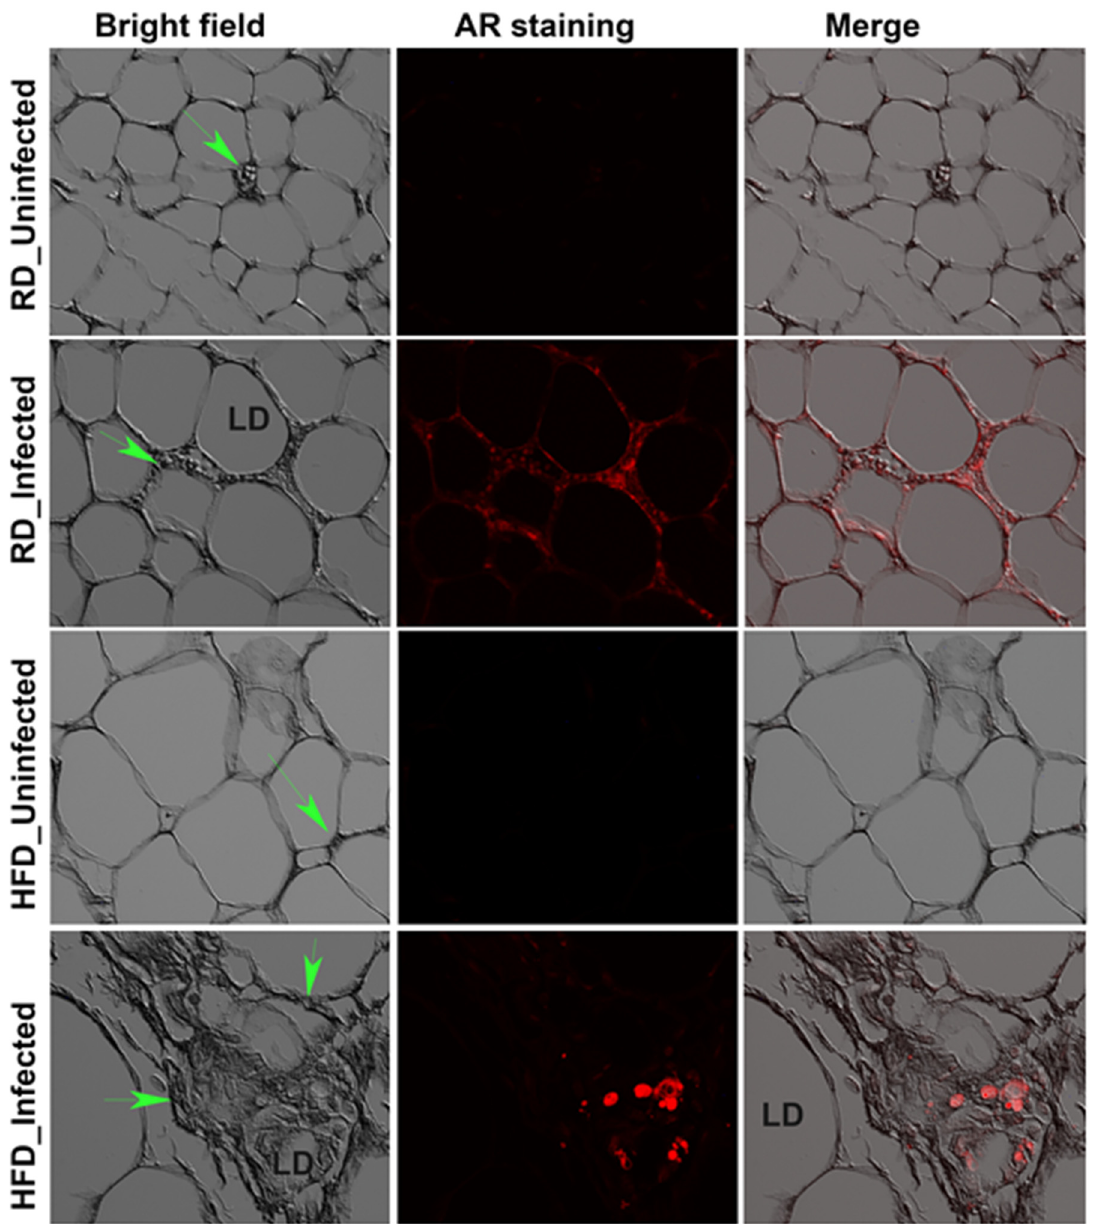
Figure 3. Mtb is present in the visceral fat sections of RD and HFD fed adult mice aerosol infected with H37Rv as demonstrated by AR staining (fluorescent red dots) at 30 dpi ( × 40 magnification). Bright field images of adipose tissue demonstrate the change in adipocyte size between RD and HFD fed mice and the merged images show the presence of Mtb (red) around dying adipocytes. Immune cells (green